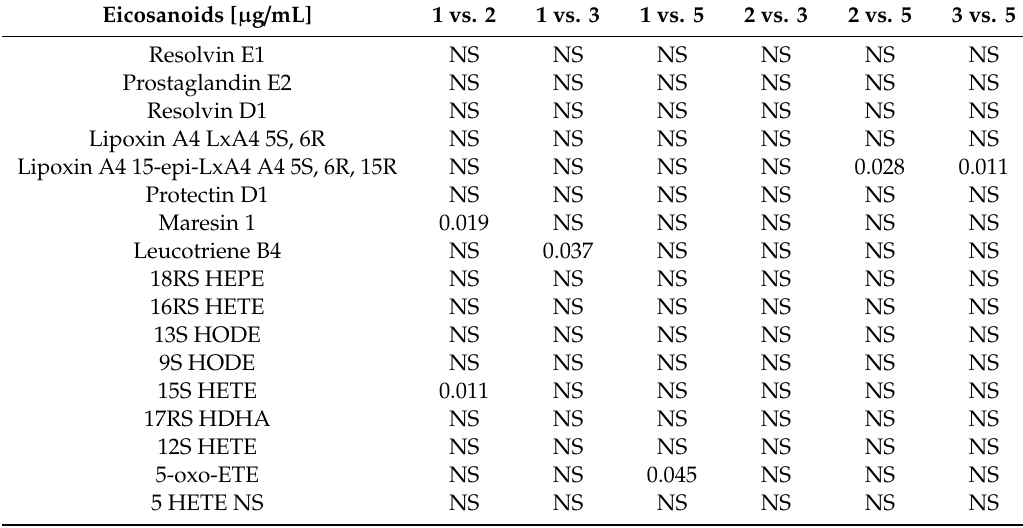
Table 8. The comparison of subgroups ( n = 74) in regard to TOAST classification and eicosanoids. Eicosanoids [ µ g /